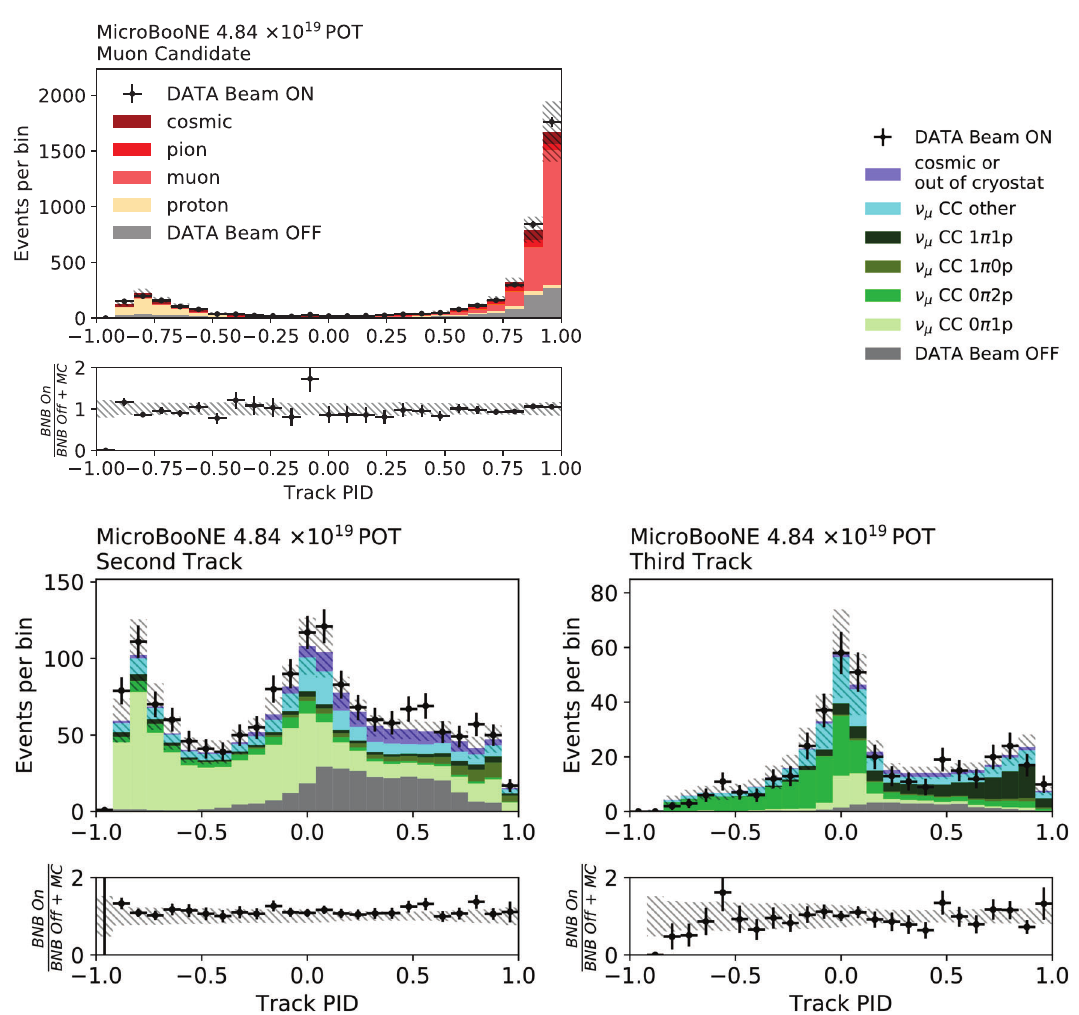
Figure 9. PID score distributions for the muon candidate track (top), the second track in events with two reconstructed tracks (bottom left), and the third track in events with three reconstructed tracks (bottom right). The DATA Beam ON (black cross) is compared with the prediction based on the sum of the simulation of neutrino interactions (stacked histogram) and DATA Beam OFF (gray bars). The selections are based on reconstructed quantities, while the prediction is broken down into different categories based on truth information. In the first plot the different colors correspond to different particle types, while in the other two they correspond to different final states. The uncertainties shown on the data points are the expected statistical uncertainties from Poisson counting, while the hashed patches on the stacked histogram illustrate systematic uncertainties on the prediction related to the simulation of the neutrino flux and interaction